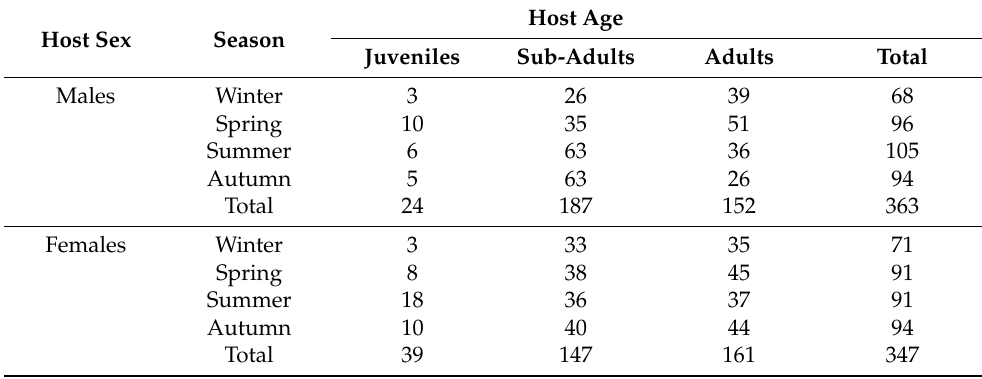
Figure 2. An individual of Microtus lusitanicus in its natural habitat. Table 1. Distribution of Microtus lusitanicus analysed by host sex and age and season of capture.